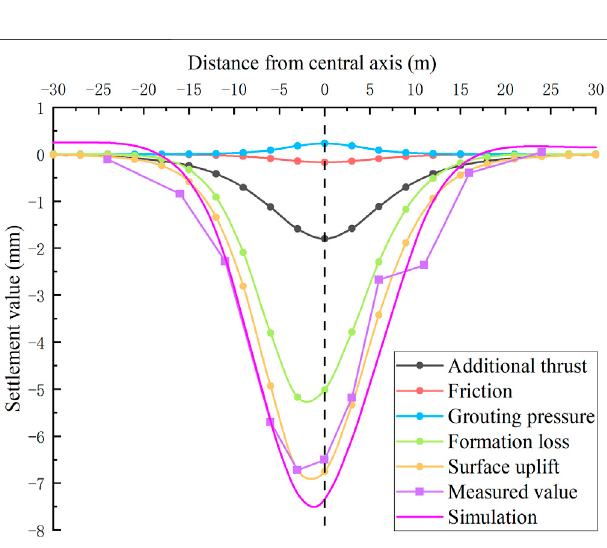
FIGURE 10 | Lateral surface deformation of Section 1 .